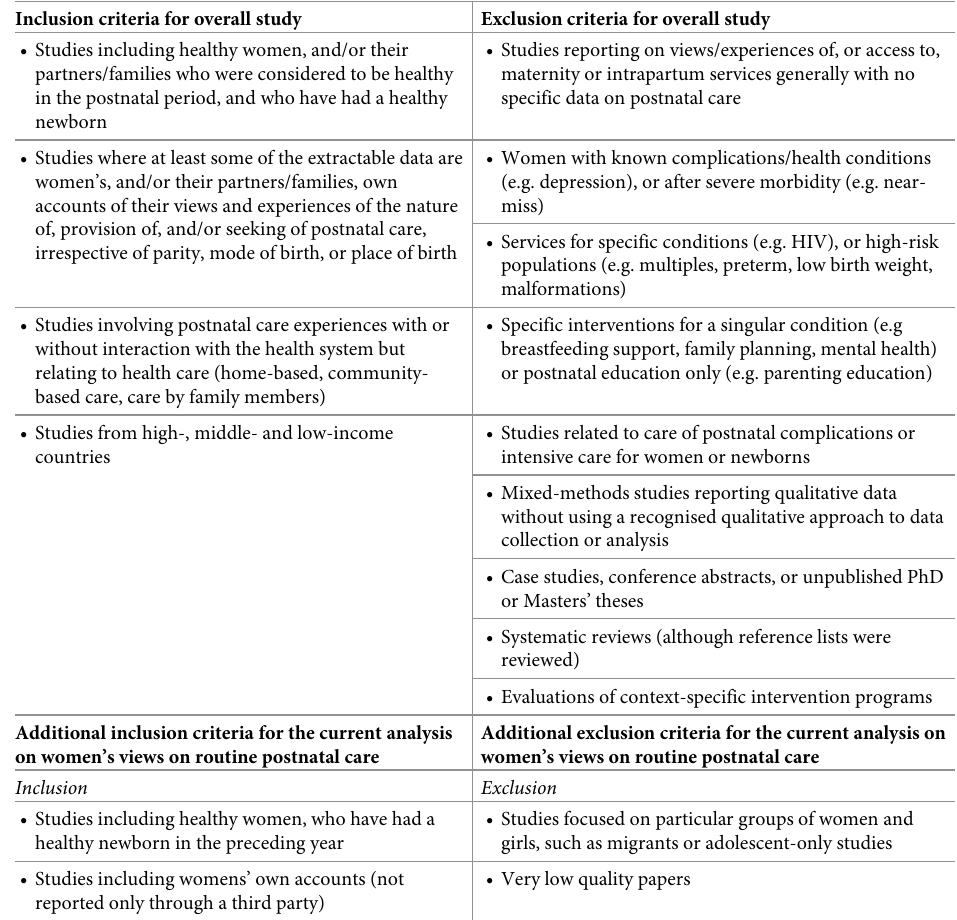
Table 1. Inclusion and exclusion